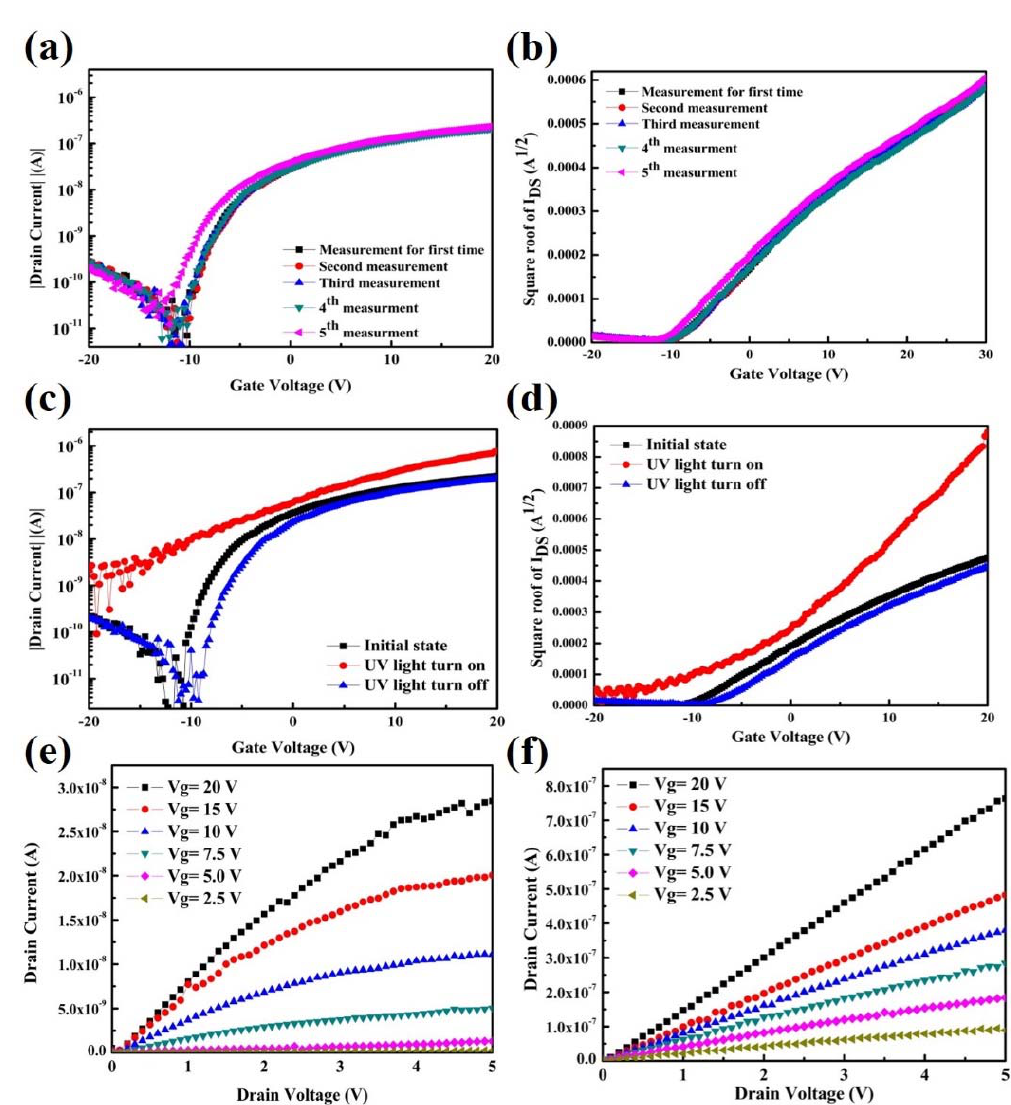
Figure 4. Electrical characteristics of ultraviolet light photodetector based on ZnO thin-film transistors. ( a ) Electrical performance endurance test performed 5 times by applying a drain current with the bottom gate voltage varying from negative 20 to positive 20 V in steps of 250 mV and the drain voltage fixed at 5 V and ( b ) square root of the drain current-gate voltage transfer characteristic curves. ( c ) The I DS – V GS curves of the photodetector under darkness, under UV illumination and with the UV light turned off and ( d ) square root of the electrical characteristics. ( e ) Typical drain current as a function of the drain voltage with the bottom gate voltage varying from 2.5 to 20 V under darkness and ( f ) UV illumination.